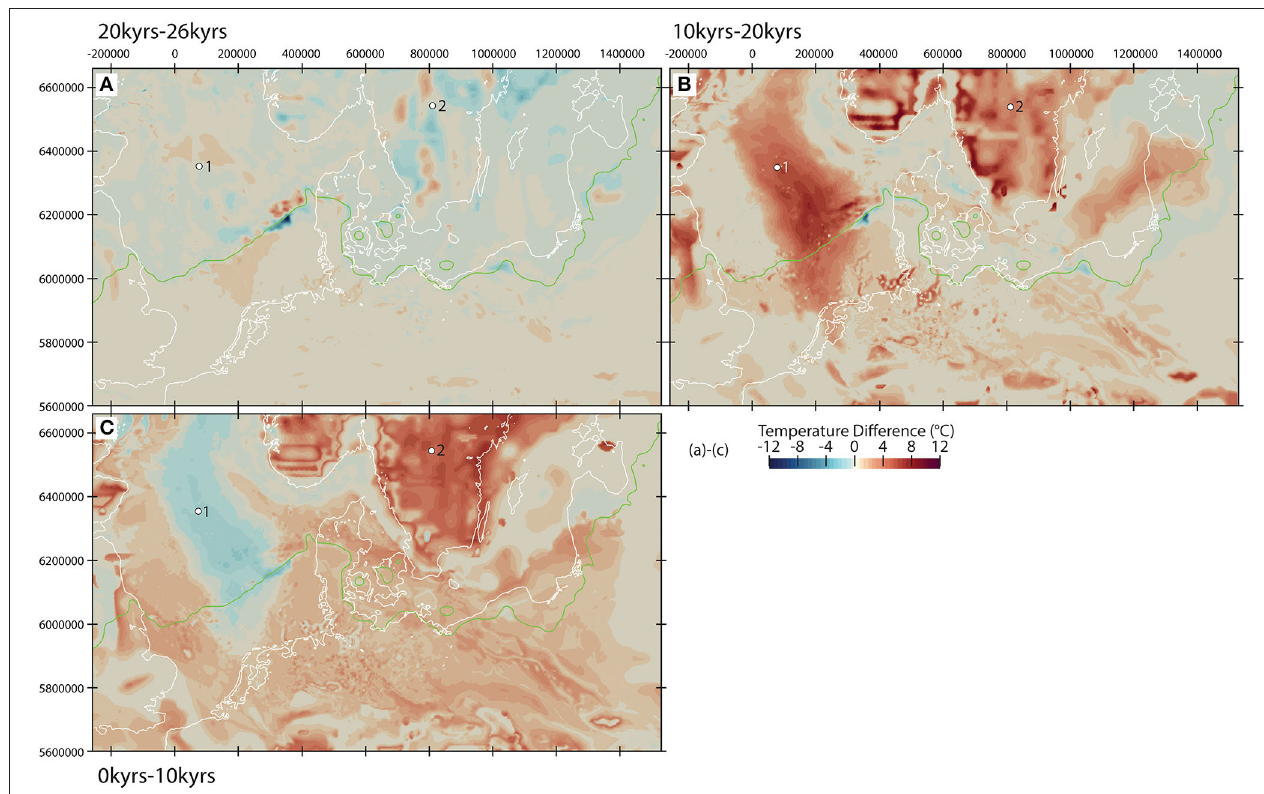
FIGURE 6 | Temperature difference between selected time steps at − 1,000m b.s.: (A) temperature at − 20 kyrs minus temperature at − 26 kyrs, (B) temperature at − 10 kyrs minus temperature at − 20 kyrs, (C) Temperature at 0 kyrs minus temperautre at 10 kyrs, and (A–C) white lines = coastline, green line = maximum ice extent at − 22 kyrs, white dots represent extraction locations from Figure 7 : 1 = central North Sea, 2 = northern crust, Coordinates are in UTM Zone